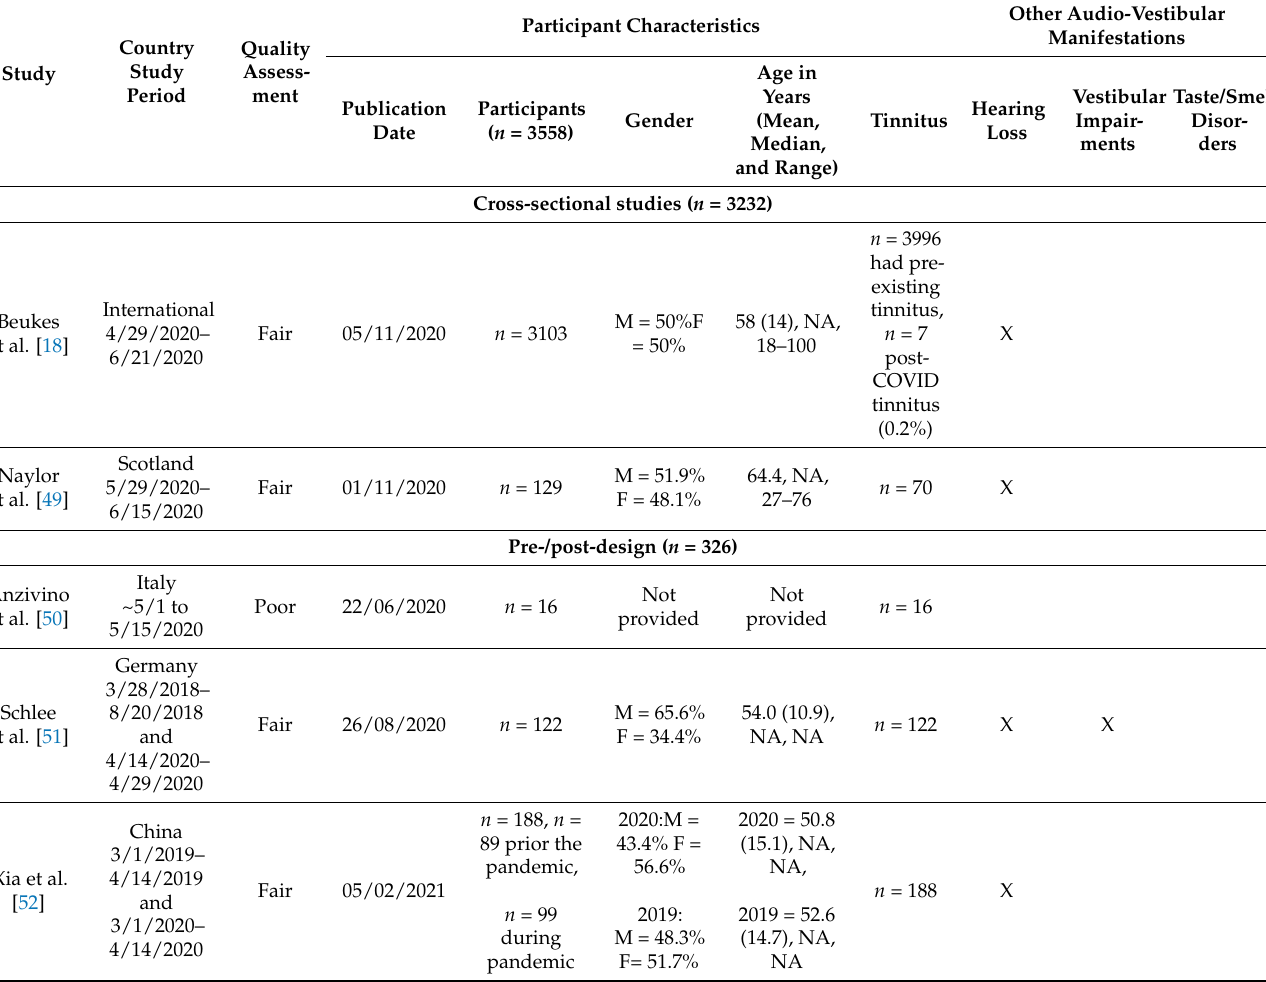
Table 4. Summary of the included COVID-19 pandemic impact